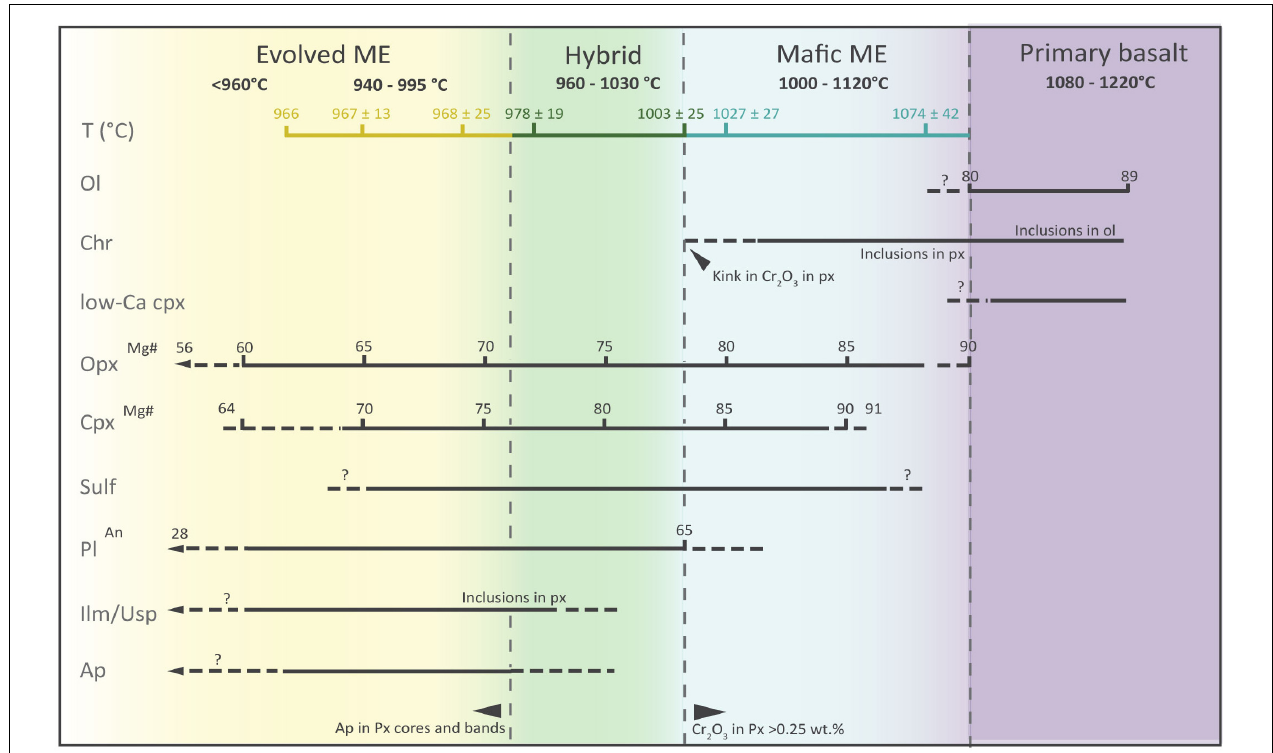
FIGURE 12 | Crystallization sequence for the PVC, combining textural and compositional results. The sequence is calibrated against orthopyroxene and clinopyroxene compositions whenever possible. Temperatures given are from Figure 7 . ME, magmatic environment. See text for